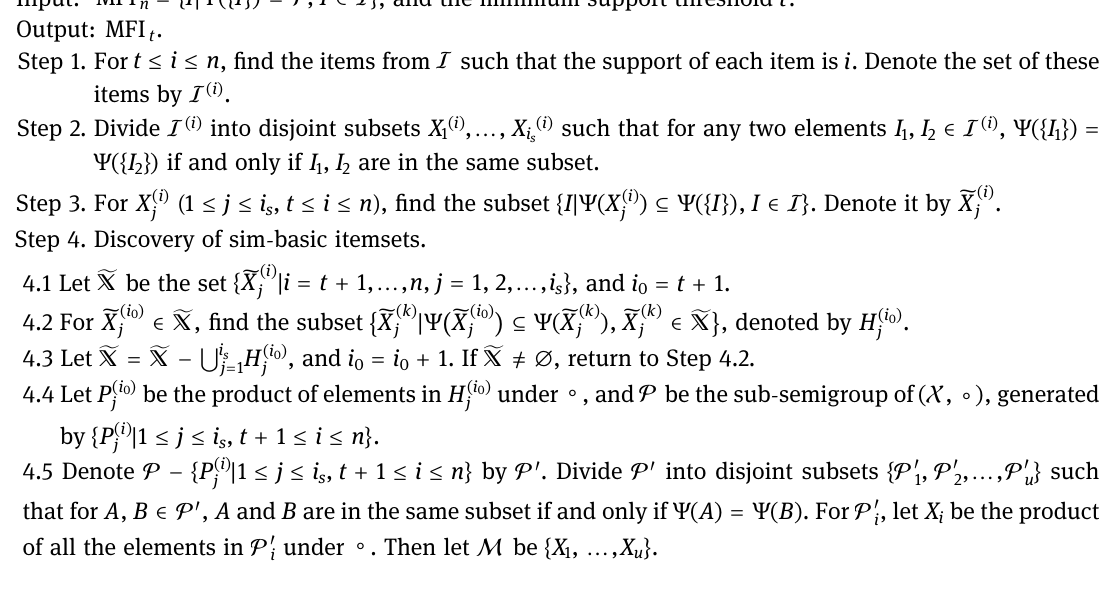
Algorithm 1. Discovery of maximal frequent